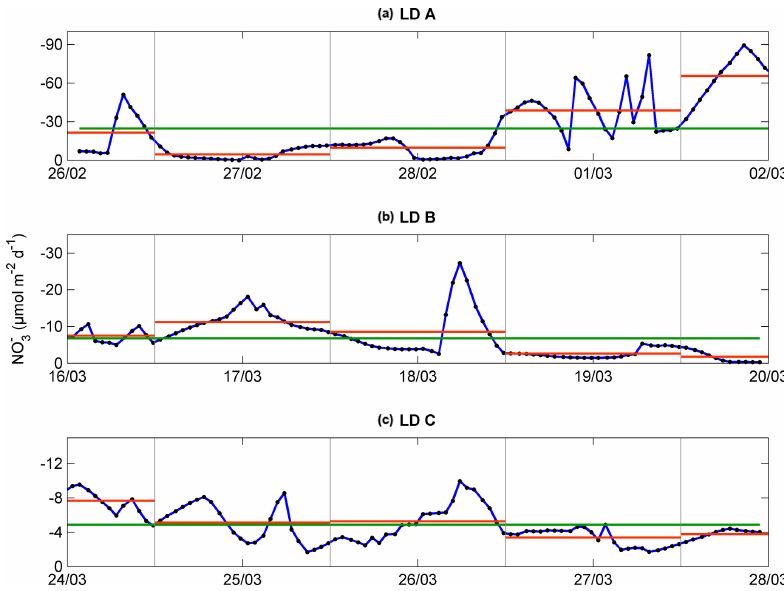
Figure 4. Temporal evolution of upward vertical NO − flux (µmolNm − 2 d − 1 ) calculated at the top of the nitracline for each station, LD A 3 (a) , LD B (b) , and LD C (c) , after temporal interpolation (blue). Daily mean from noon to noon in dashed orange line and occupation period mean in green line.